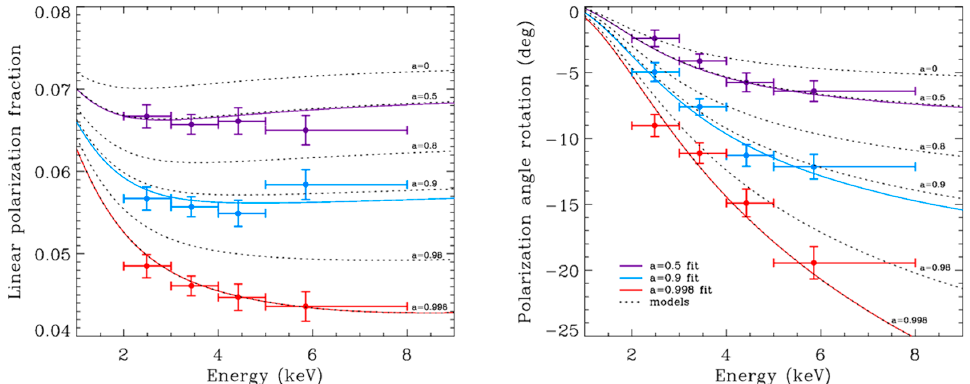
field is aligned with the direction of the jet. However, different models for electron acceleration may predict different dependences in X-rays.